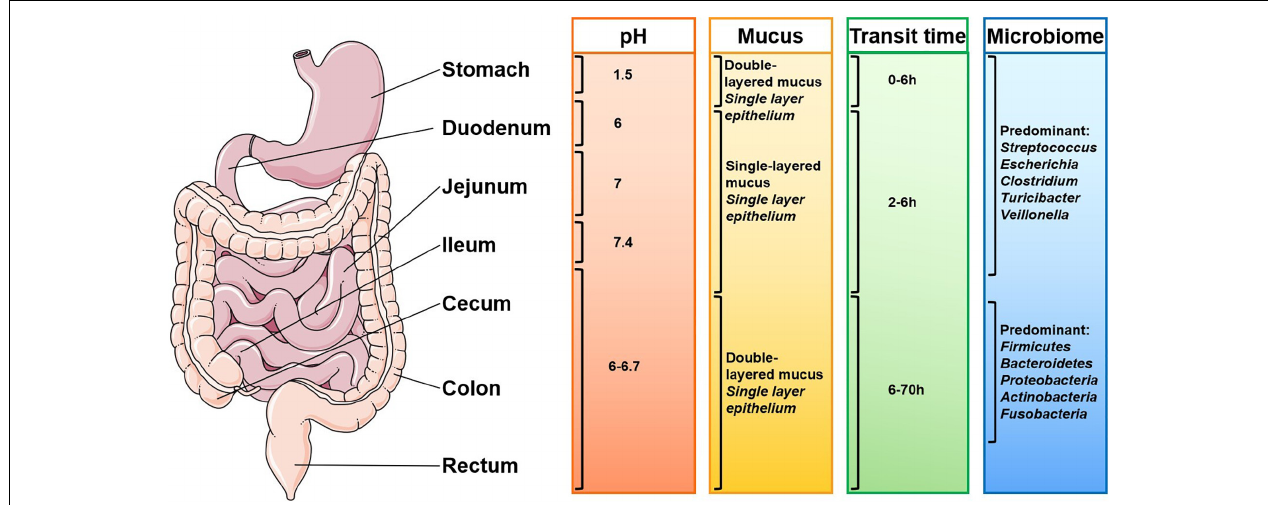
FIGURE 2 | Gastrointestinal physiological factors that influence oral drug delivery (adapted from Hua, 2020). The complex gastrointestinal (GI) environment of human beings and the differences in different individuals bring challenges to the delivery of nanoparticles. The pH of the GI tract, composition of the mucosa, microorganisms and enzymes, and the residence time of the drugs in different parts of the GI tract all affect the drug delivery